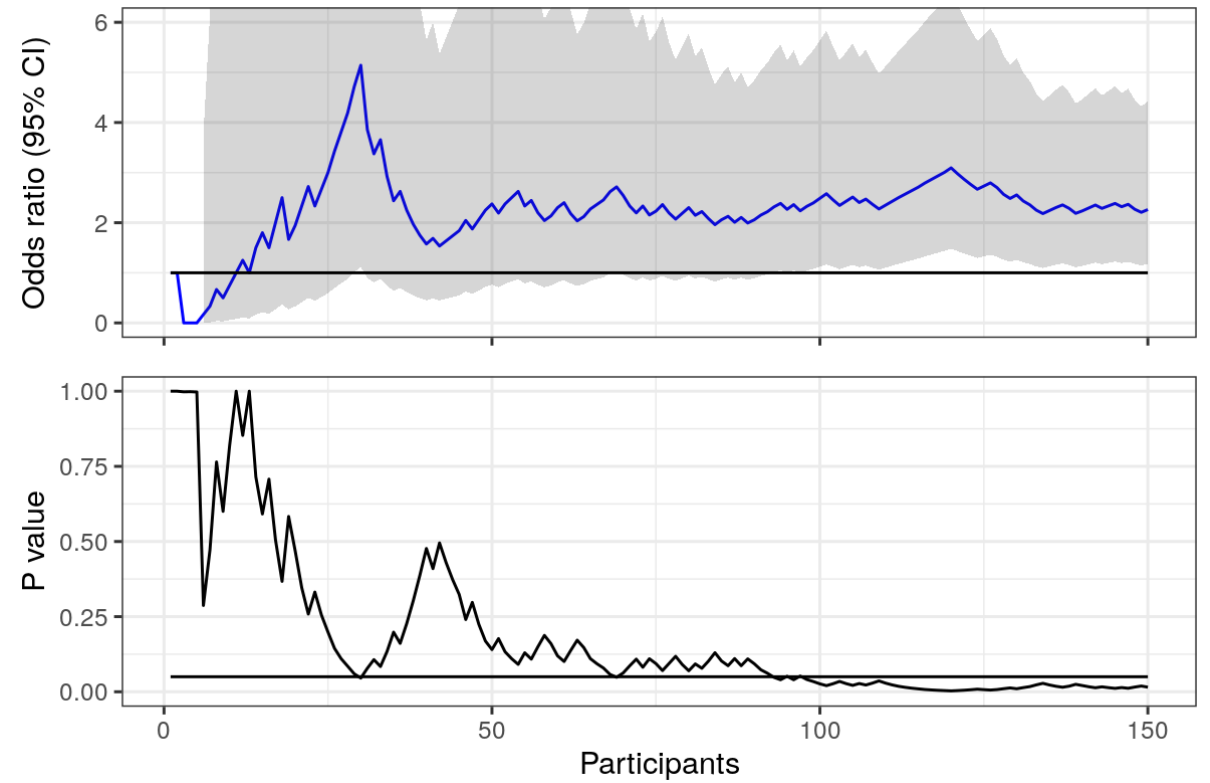
Figure 5. Pressed link in text message: odds ratios and P values calculated and plotted over time (number of participants in the study). Horizontal lines represent null value (OR 1) and the .05 statistical significance